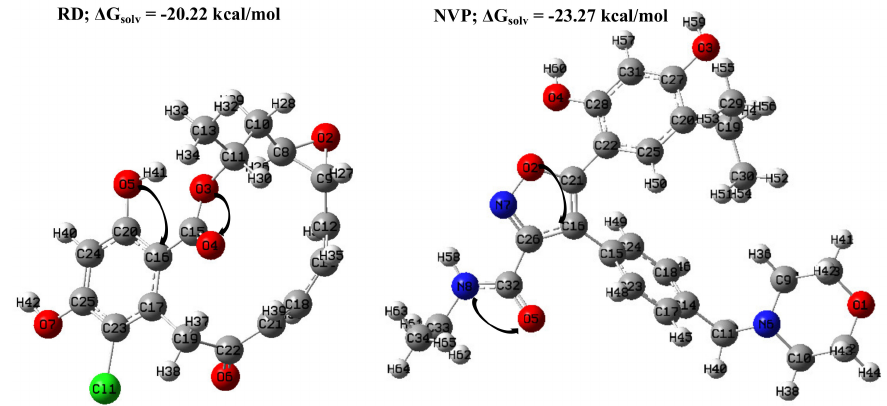
Figure 4. The optimized inhibitors at SMD / B3LYP / 6-311G(d,p) level of theory indicating some charge transfer depicted through the NBO analysis. Atom color legend; green = chlorine, grey = carbon, white = hydrogen, blue = nitrogen and red =